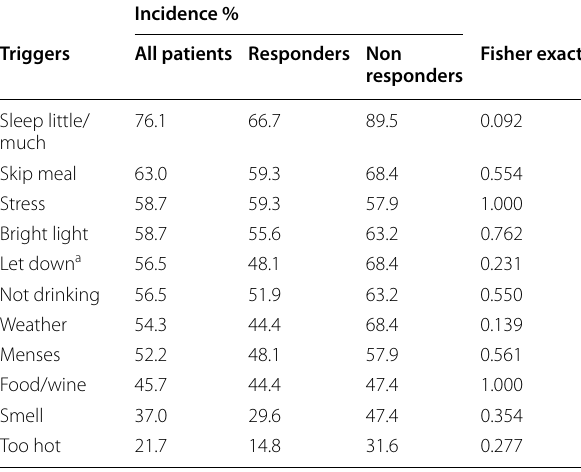
Table 6 Incidences of triggers that initiated migraine headache before treatment